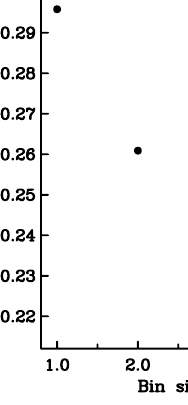
Fig. 3. P > 1 /P < 1 for nitrate data as bin size is varied from 1 to 5